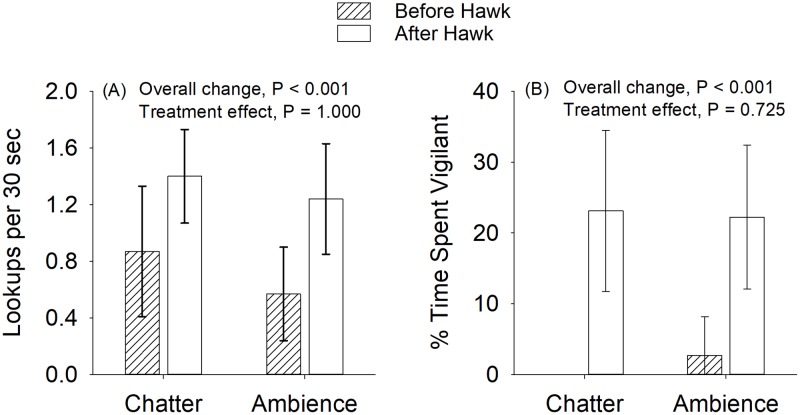
Change in vigilance behavior of squirrels in response to playback of a red-tailed hawk call.Change in vigilance behavior of squirrels in response to playback of a red-tailed hawk call, partitioned by the treatment to which squirrels were eventually exposed. Error bars represent 95% confidence intervals. Means are not adjusted for effects of habitat vulnerability. The mean value for % Time Spent Vigilant prior to the hawk call for squirrels eventually exposed to the chatter treatment was 0, with no variance.